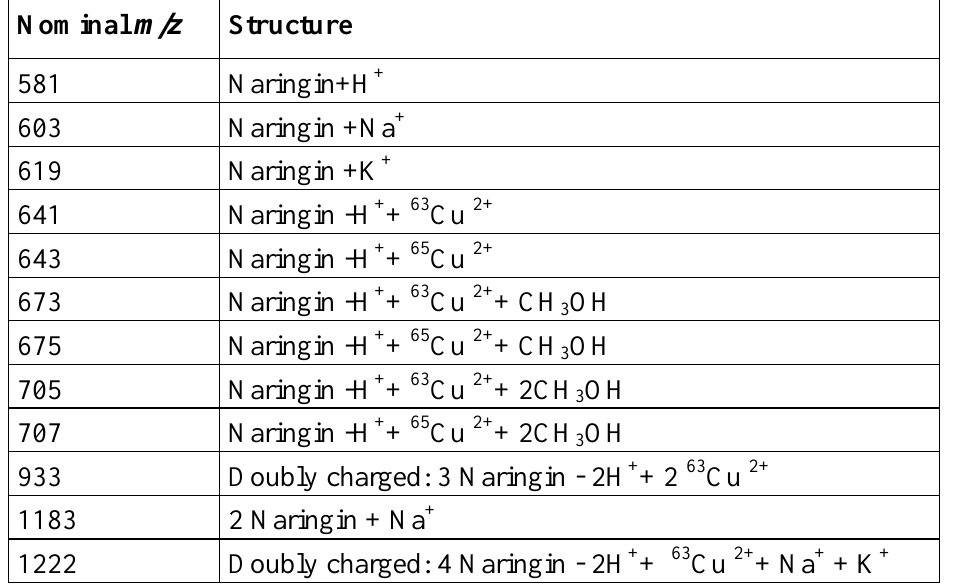
Table 1. Nominal m/z of the ions observed in the positive ion mode ESI-MS fingerprint of the NAR/Cu sample and the identified